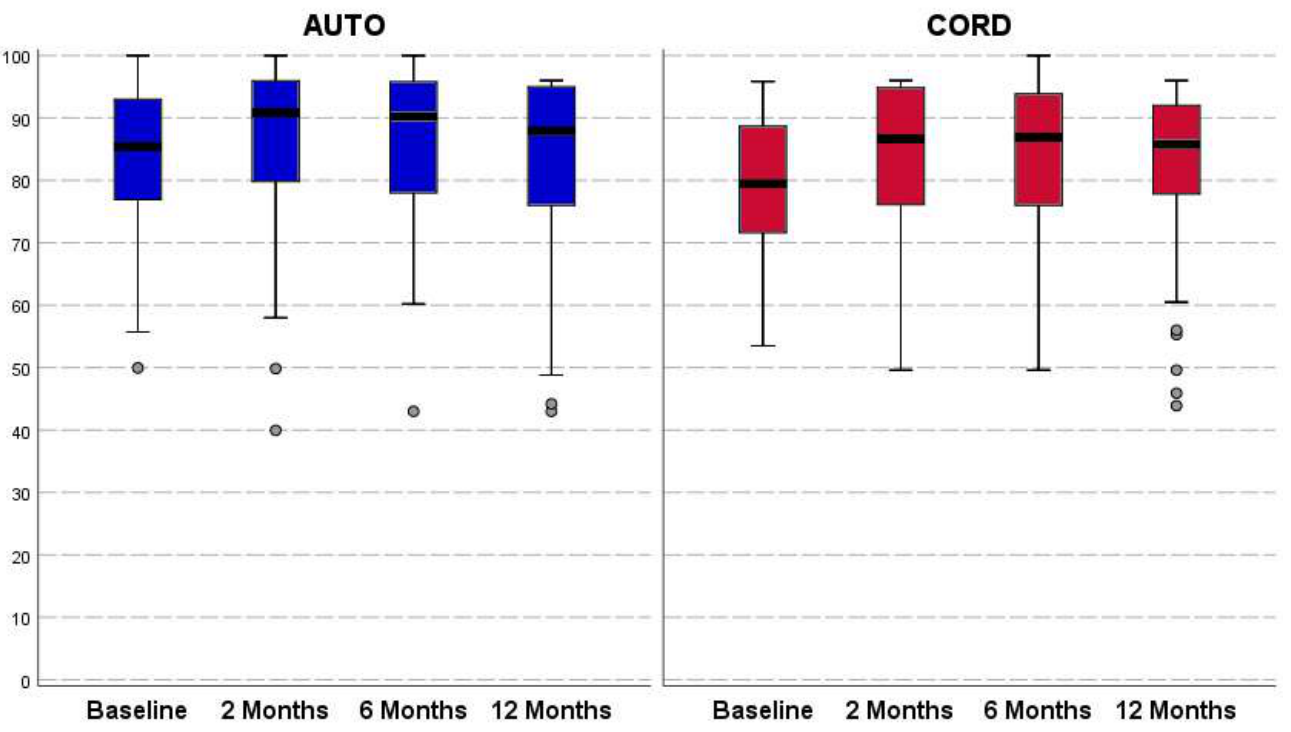
Figure 2. Harris Hip Score (HHS; 0–100 points) trends in both treatment groups. The horizontal black line represents the median, the box limit represents quartiles, and error bars represent 95% Confident Intervals.